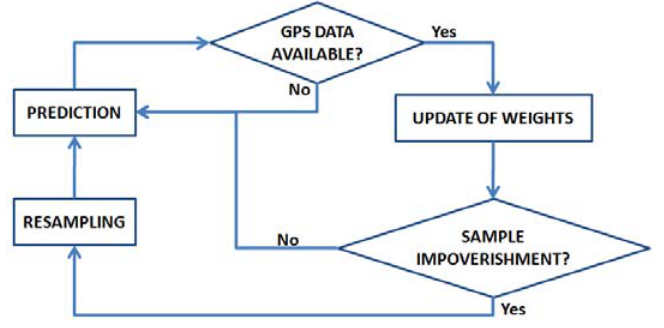
Figure 8. Block diagram of the Bayesian particle